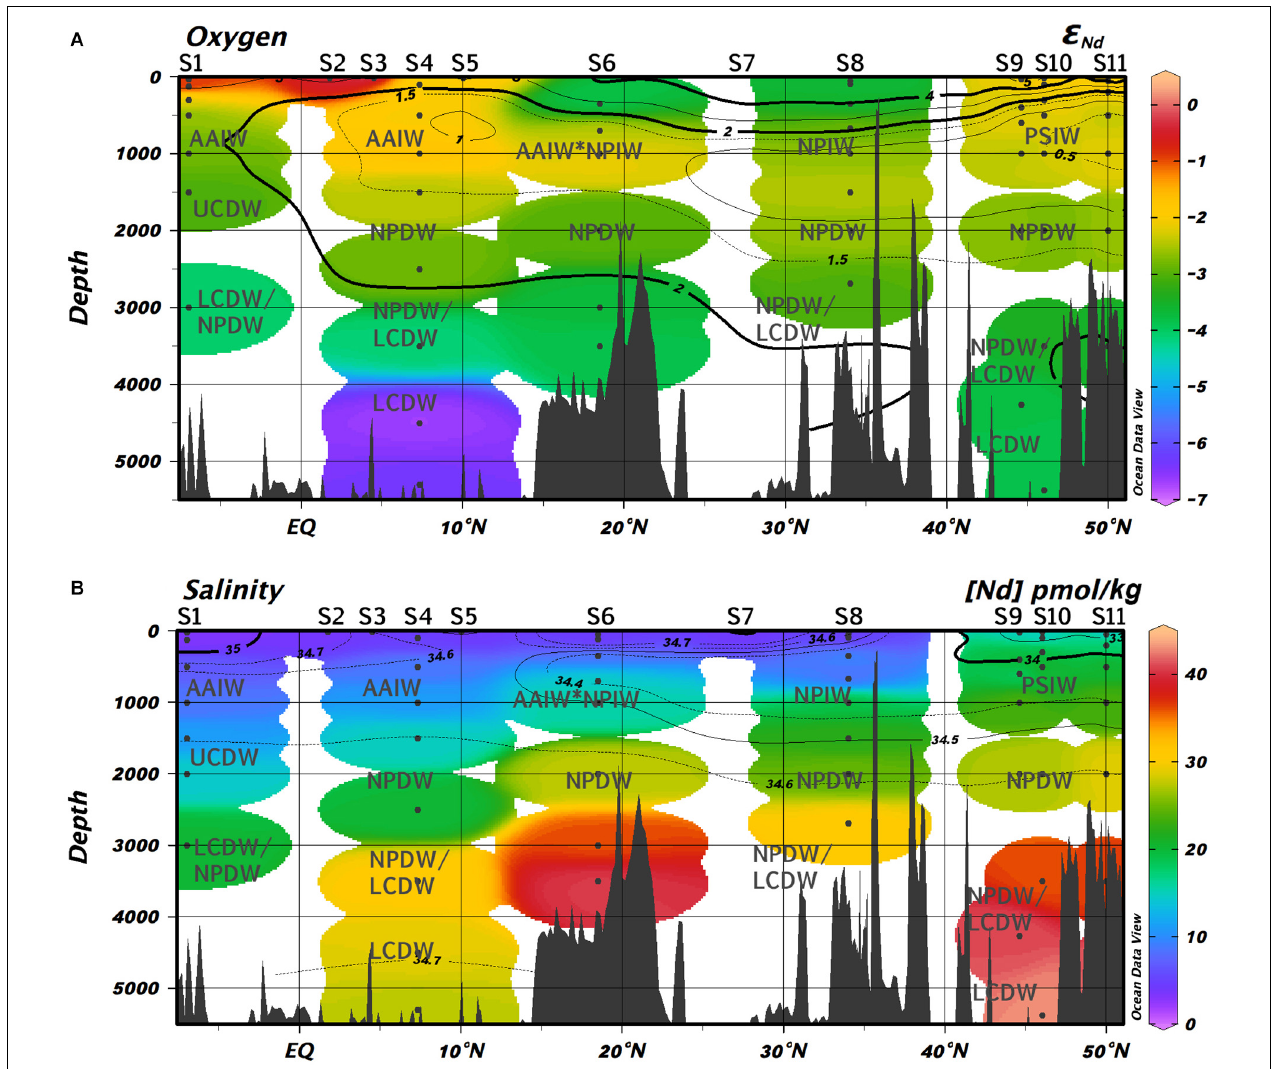
FIGURE 4 | Color-coded ε Nd and [Nd] along a longitudinal section (168.5 ◦ E to 179.8 ◦ W) from ∼ 7 ◦ S to ∼ 51 ◦ N. The proxy distribution patterns are underlain by oxygen (A) and salinity (B) isolines which outline the various water masses discussed in the text. Created by using Ocean Data View (Schlitzer, 2020) and further